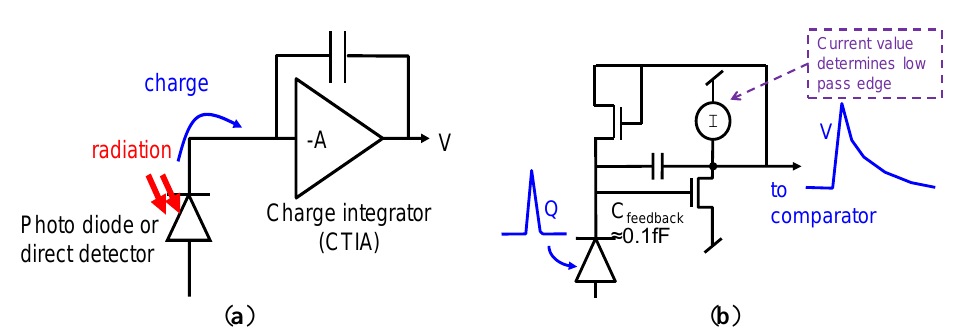
Figure 2. Topology of the QX2010 pixel.